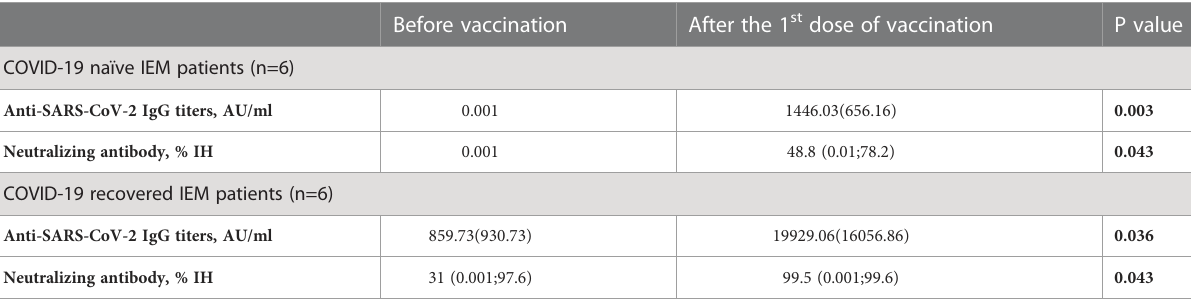
TABLE 3 Evaluation of Anti-SARS-CoV-2 IgG titers and neutralizing antibody IH% activity after the fi rst dose of BNT162b2 vaccination in patients with inborn errors of metabolism. Before vaccination After the 1 st dose of vaccination P value